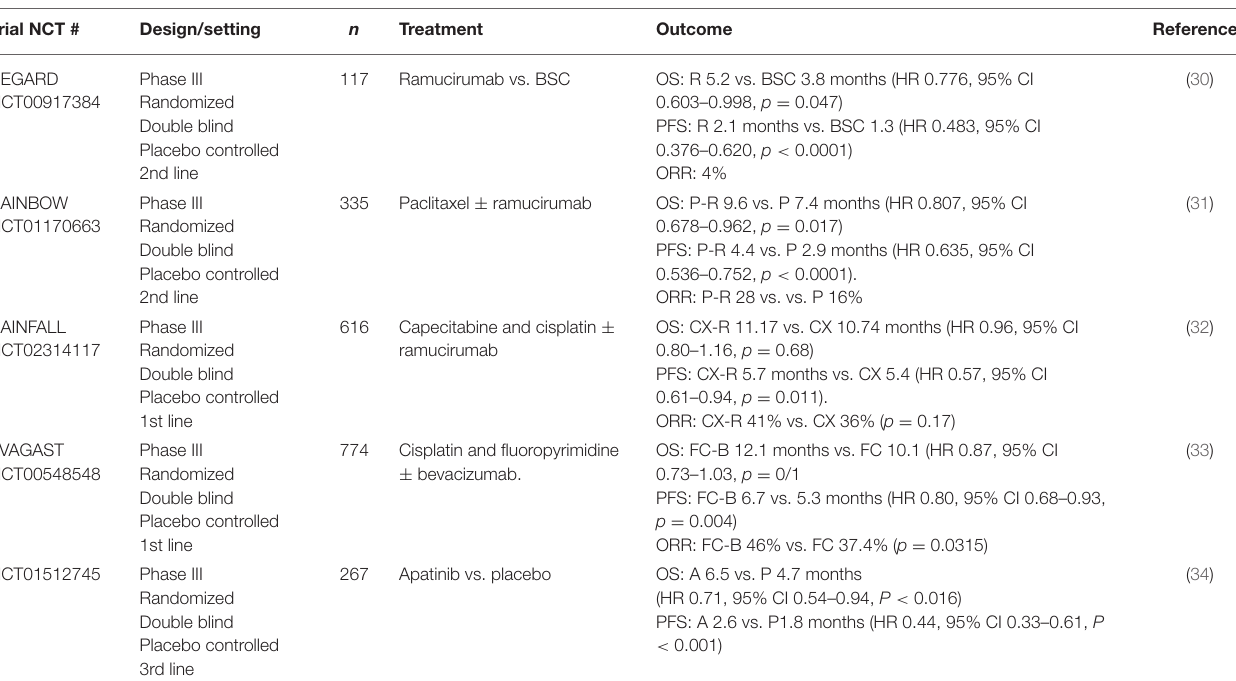
TABLE 1 | Selected Phase III studies targeting VEGF in OG cancer.